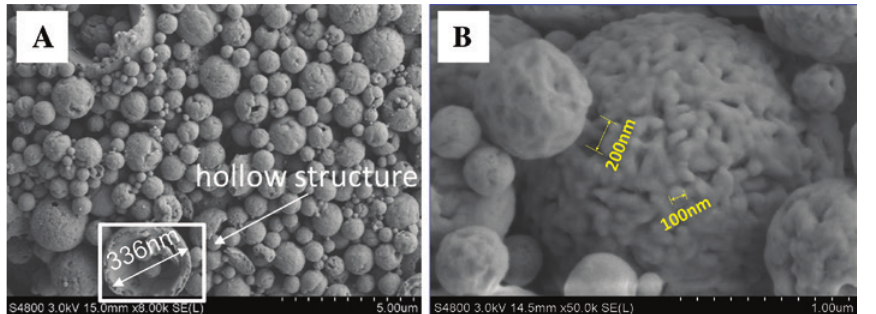
by ultrasonic spray pyrolysis of cerium 2